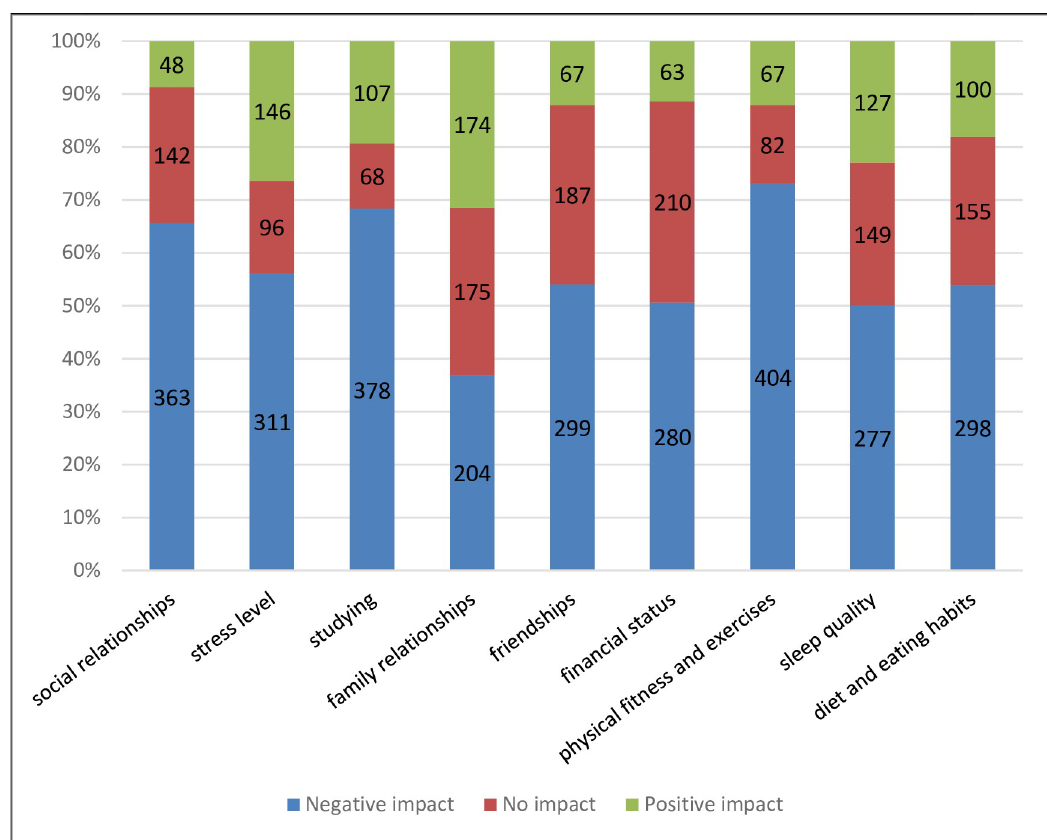
Fig 1. The impact of Covid-19 on different aspects of medical students’